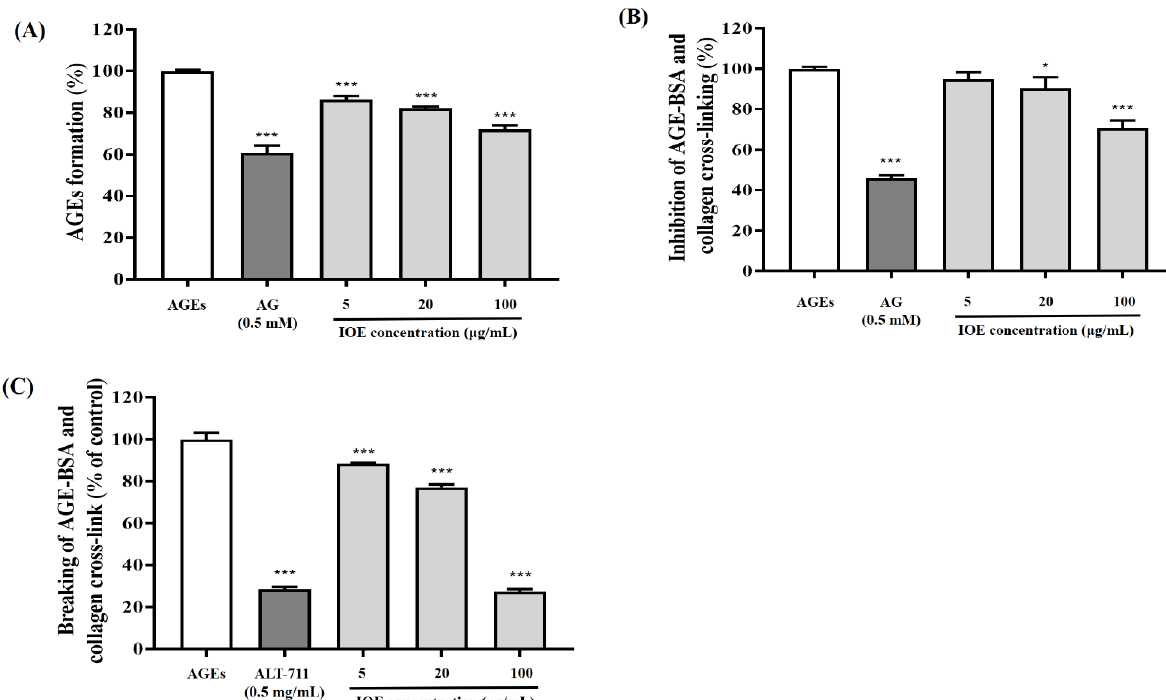
Figure 2. Effects of the Ishige okamurae extract on AGE-induced glycation reaction in vitro. Inhibition of AGE formation ( A ), inhibition of AGEs-BSA and collagen cross-link formation ( B ), and breaking of AGEs-BSA and collagen cross-links ( C ). Bar values are expressed as mean ± standard deviation ( n = 6) (* p < 0.05 and *** p < 0.001 vs. AGEs).